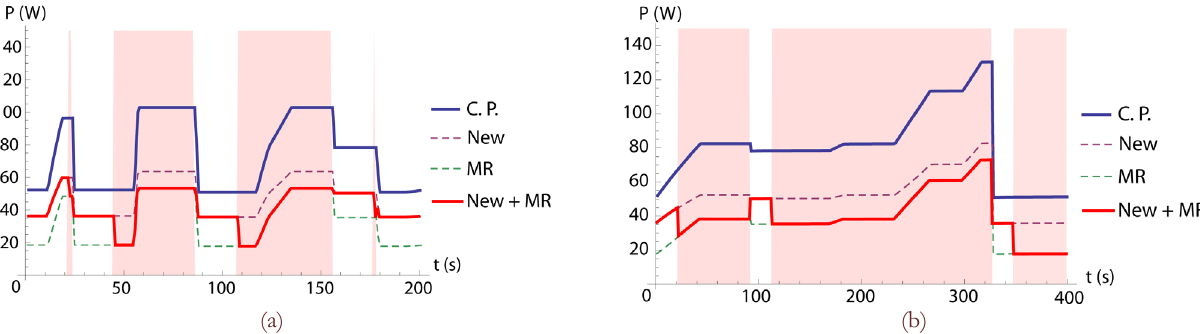
Figure 15: Power absorbed by current production, innovative vacuum pump and MR prototype during urban (a) and extra-urban (b) cycles.